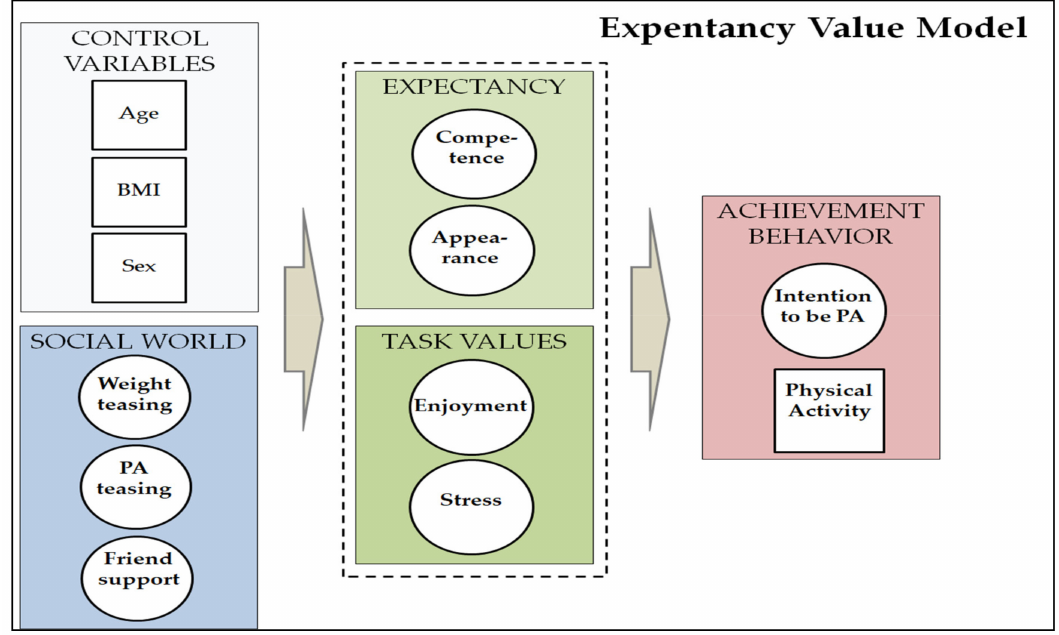
Figure 1. Explanatory model of physical activity behavior and intention to be physically active, adapted from Eccles et al.